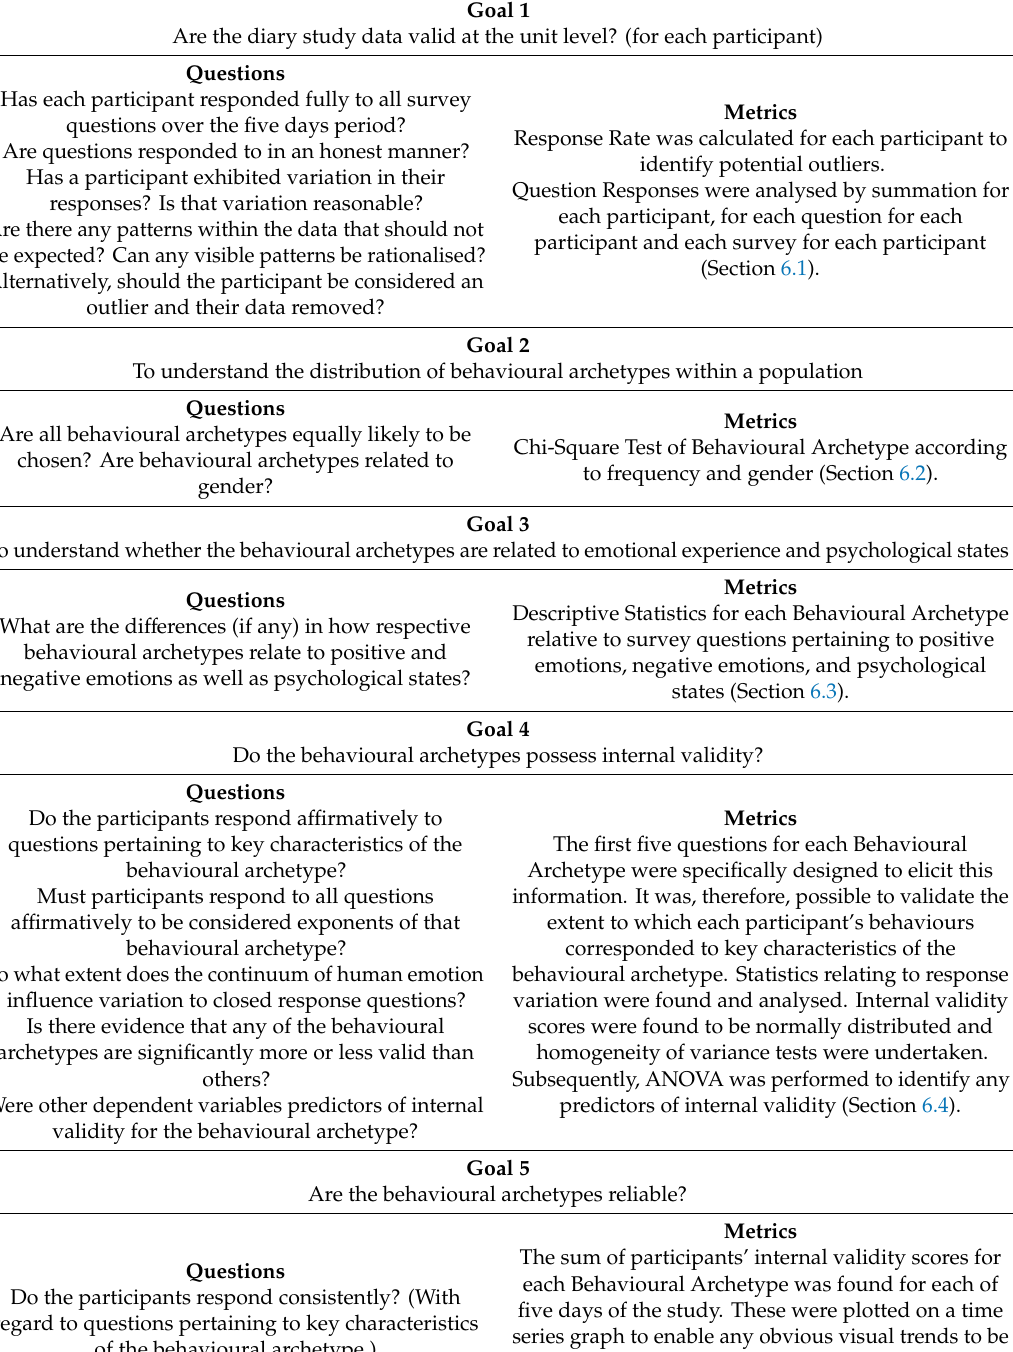
Table 10. Evaluating our behavioural archetypes through Goal Question Metrics (GQM)